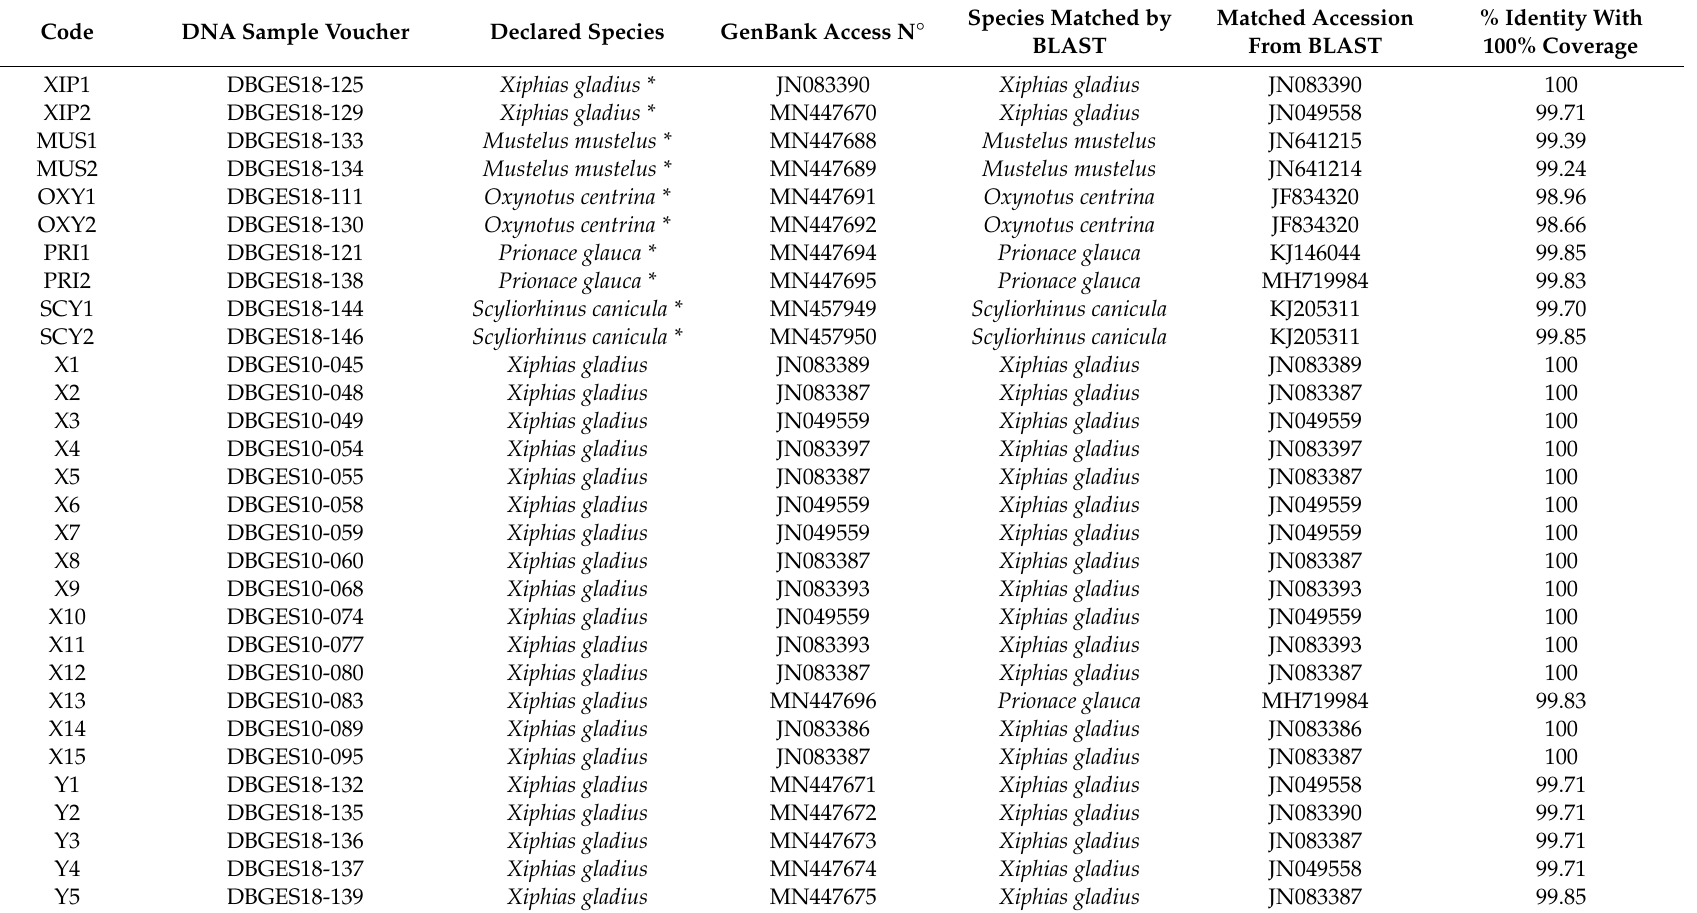
Table 1. Samples examined in this